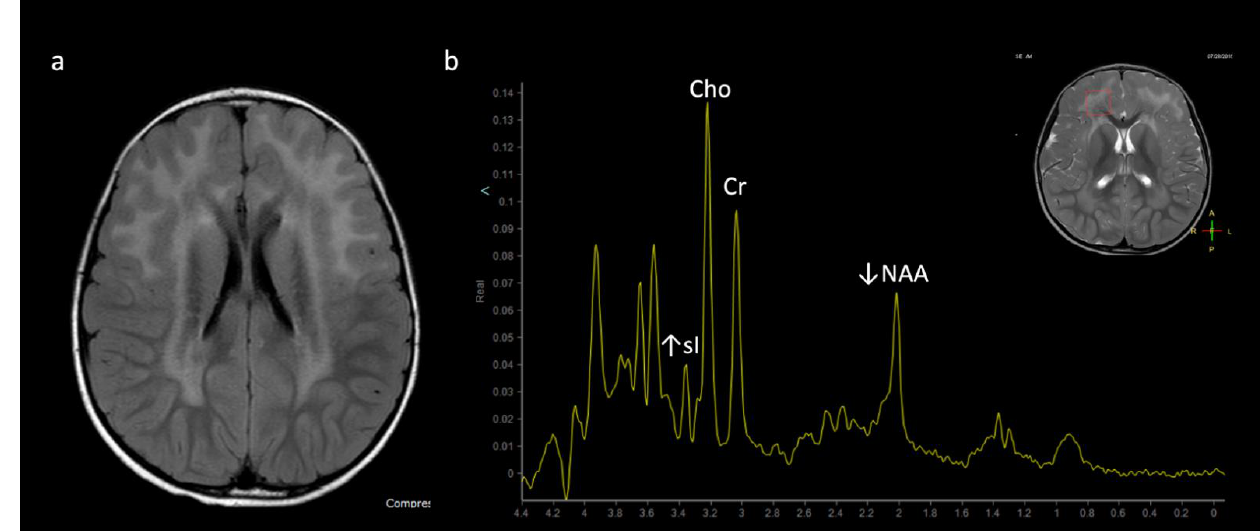
Figure 15. Alexander disease in a 3-year-old female with dysmorphic features and developmental delay. ( a ) Axial T2 FLAIR image demonstrates widespread hyperintense white matter signal involving the subcortical U fibers only in the frontal regions consistent with a leukodystrophy with an anteroposterior severity gradient. ( b ) SV-MRS of the right frontal white matter shows slightly elevated Lac, reduced NAA, and elevated scyllo-inositol at 3.36.